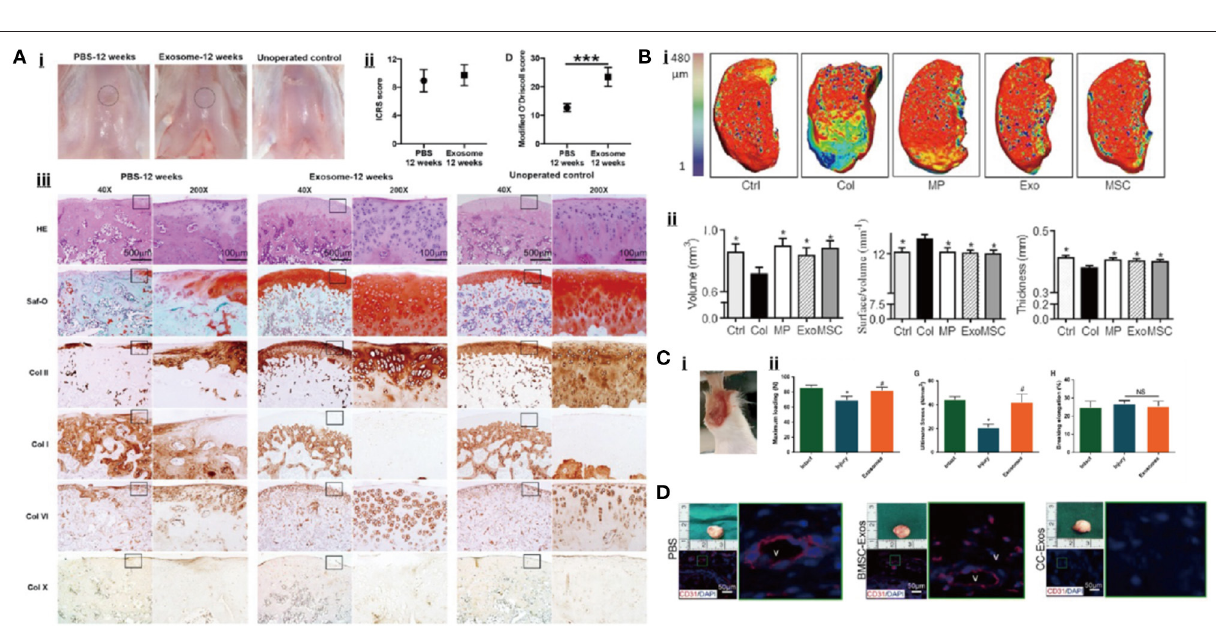
FIGURE 6 | Exosomal therapeutic effect in cartilage repair. (A) Cartilage tissue regeneration in rat after the treatment (Zhang et al., 2016). (B) Exosomes can regenerate the cartilage tissue in a mice OA model (Cosenza et al., 2017). (C) The therapeutic effect of exosomes for tendon repair (Wang et al., 2019). (D) Exosome promotes the vascular formation within the bone (Chen et al.,